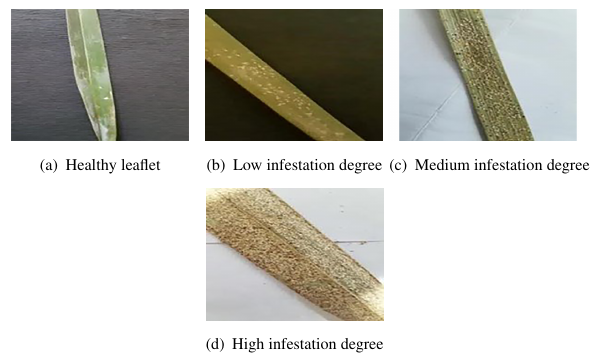
Fig. 4 Samples of healthy and infected leaflets.